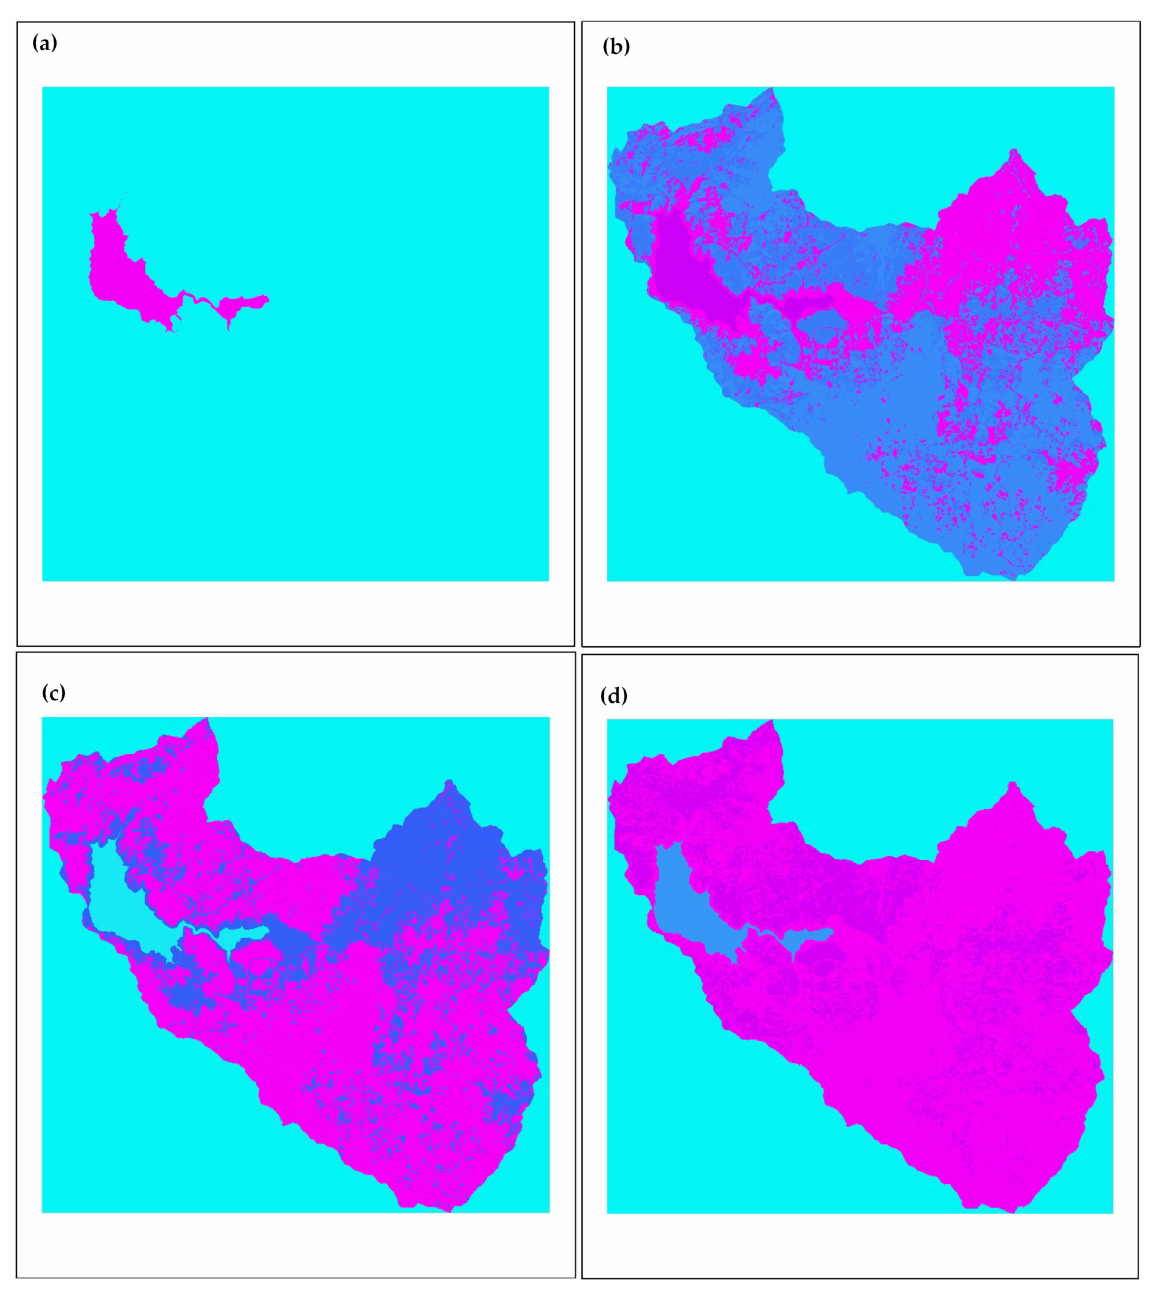
Figure A2. ( a ) Waterbody “land suitability” for the year 2038; ( b ) Bareland “land suitability” for the year 2038; ( c ) Forest “land suitability” for the year 2038; ( d ) Agricultural “land suitability” for the year